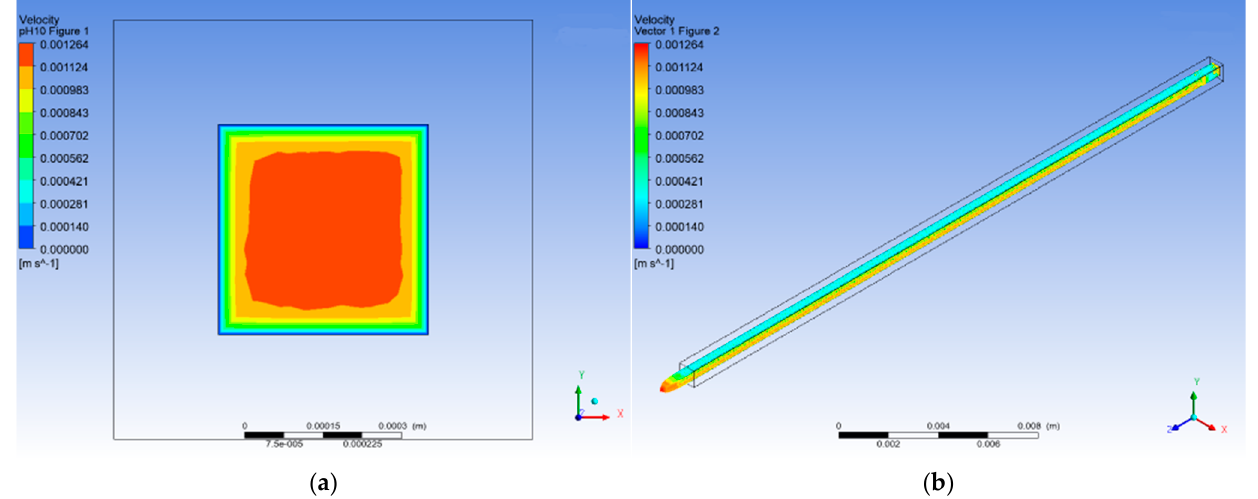
Figure 13. CFD numerical analysis results (pH 10): ( a ) contour; ( b ) vector. Here, (cid:1874) (cid:3029) : velocity coefficient at the bottom of the capillary tube, (cid:1874) (cid:3046)(cid:3030) : velocity coeffi- cient at the central side of the capillary tube, (cid:1874) (cid:3040)(cid:3030) : speed factor at the center of the capillary tube, and pH: pH of heavy metal contaminants are shown. 4. Conclusions In this study, a microfluidic flow experiment was performed to apply a hydrophilic hydrophobic filter for selective remediation of heavy metal copper contaminated ground. Accordingly, the summary of the results of this study is as follows. (1) As a result of microfluidic flow experiments for heavy copper metal contaminants, it was confirmed that the movement of contaminants was small in locations where the influence of hydrophobic properties was large. This means that hydrophobic surfaces can slow down the flow of hydrophilic heavy metal contaminants. (2) The analysis of the flow rate according to each experimental condition confirmed that the change in flow rate of pH conditions was an influential factor. It was confirmed that the flow rate increased as the pH was more basic, and it was confirmed that the hydrophobic properties slightly decreased under basic conditions. (3) Numerical analysis was performed by applying the contact angle, which is a hydro- phobic characteristic, however, it was difficult to compare and analyze through CFD analysis. Based on the flow rate according to pH as a result of the experiment, the velocity coefficient was proposed through regression analysis. Using the velocity co- efficient, it is determined that the flow rate according to pH on a hydrophobic coated surface can be determined. In this study, it was confirmed that heavy metal contaminants were slowed down through hydrophobic coating. Through additional laboratory and filed tests, selective re- mediation is possible in the ground contaminated with heavy metals and organic. Author Contributions: Conceptualization, J.-G.H. and G.H.; methodology, J.-G.H. and G.H.; vali- dation, J.-G.H., J.-Y.L. and G.H.; formal analysis, D.J. and D.K.; investigation, D.J., J.-Y.L. and D.K.; resources, J.-G.H., J.-Y.L. and G.H.; data curation, D.J. and D.K; writing—original draft preparation, D.J. and D.K; writing—review and editing, J.-G.H., D.J., J.-Y.L., D.K. and G.H.; visualization, J.-G.H.,